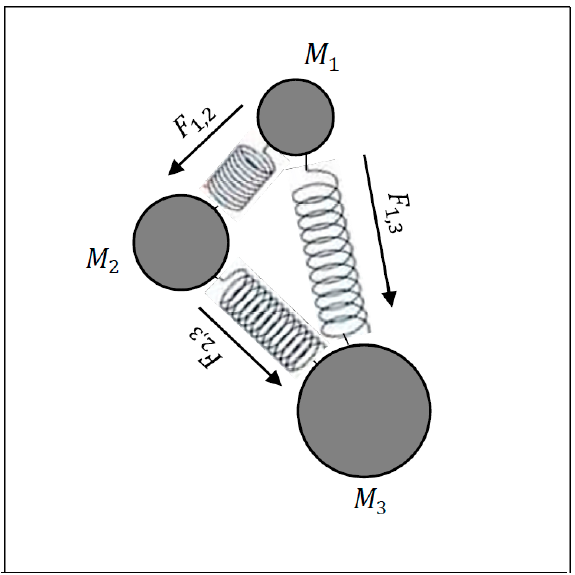
Figure 3. Forces in the system of objects and springs.